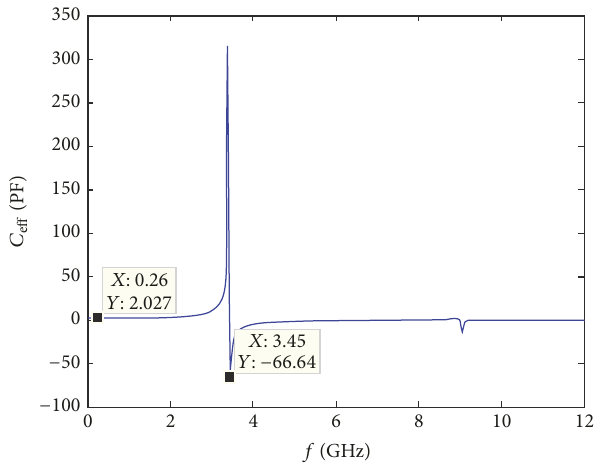
Figure 13: The effective capacitance of the capacitor.